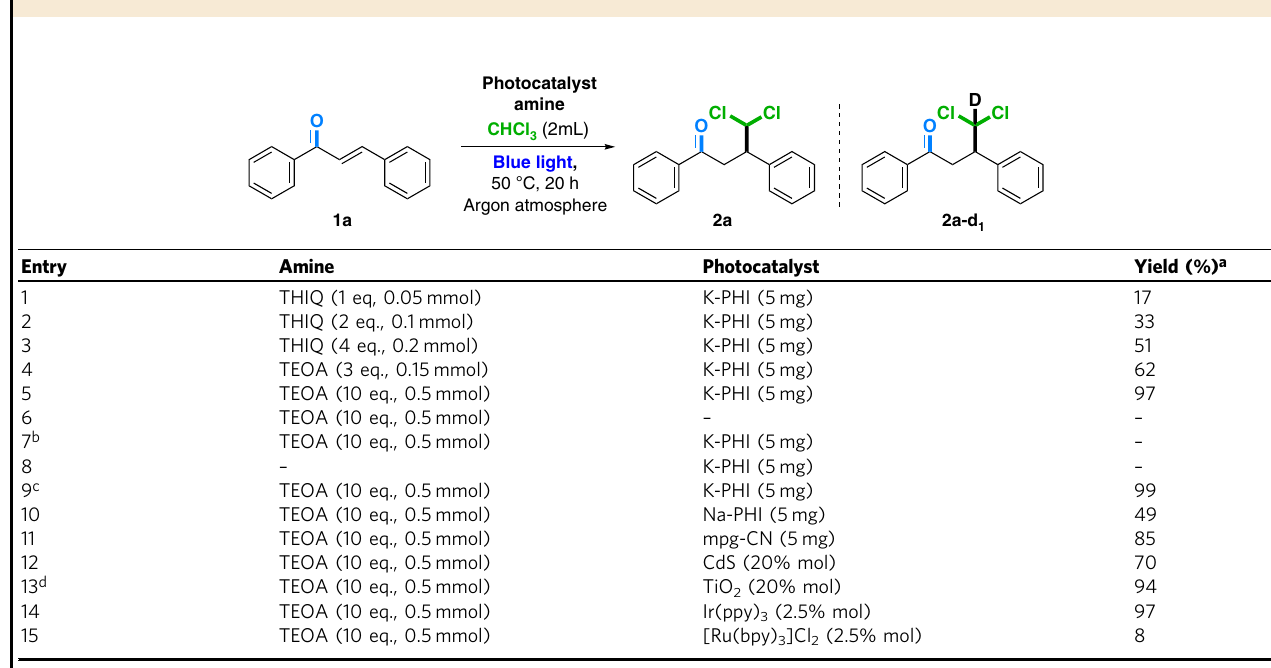
Table 1 Screening of reaction